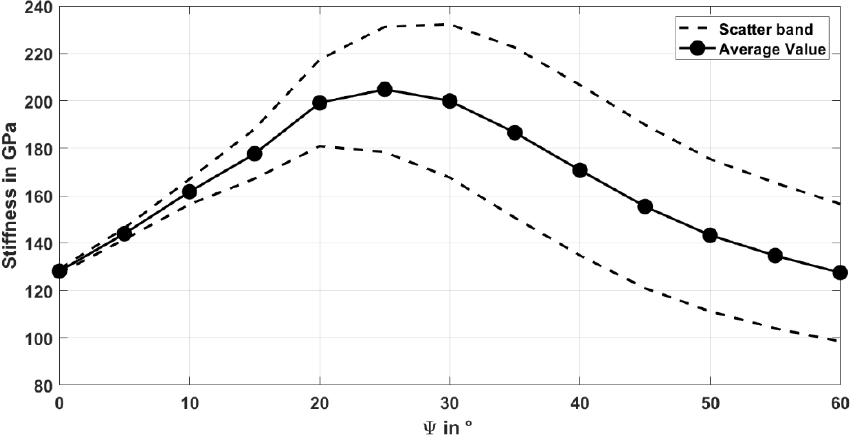
Figure 16. Development of stiffness along the notch for the textured material.